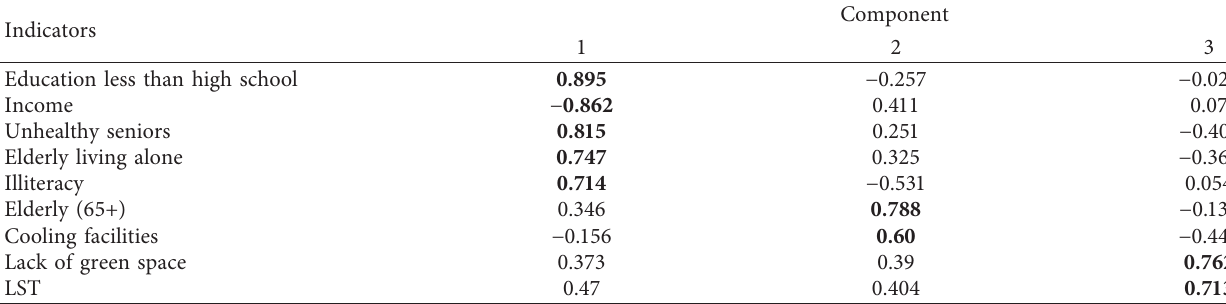
Table 5: Component matrix from the PCA method.